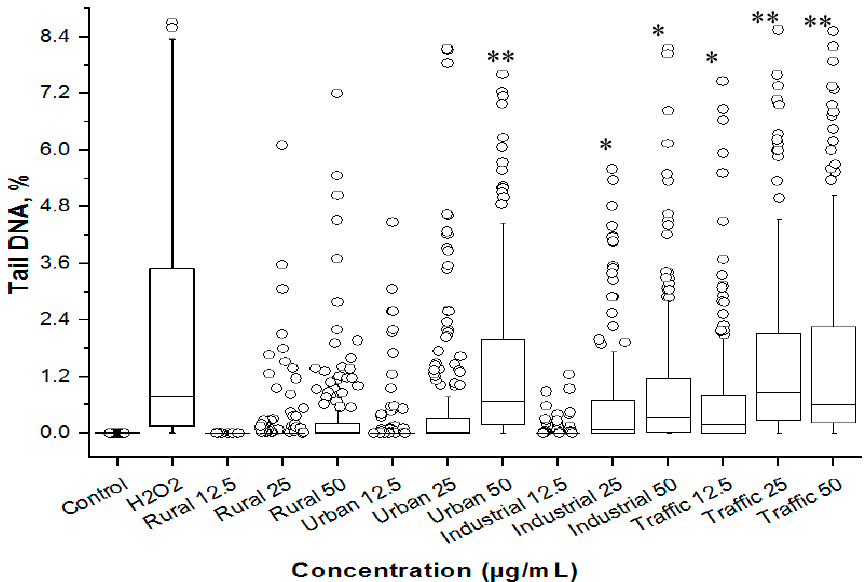
Figure 4. Box-and-whisker plot of the distribution of DNA damage (% tail DNA) in A549 cells treated with PM 2.5 for 24 h at 37 °C and measured using the alkaline comet assay. The boxes include 50% of the data. The inner line marks the median value and whisker lines extending from the box represent the minimum and maximum values. H 2 O 2 (100 mM, 5 min at 37 °C) was used as the positive control. Small circles represent outliers. * p < 0.05; ** p < 0.01.